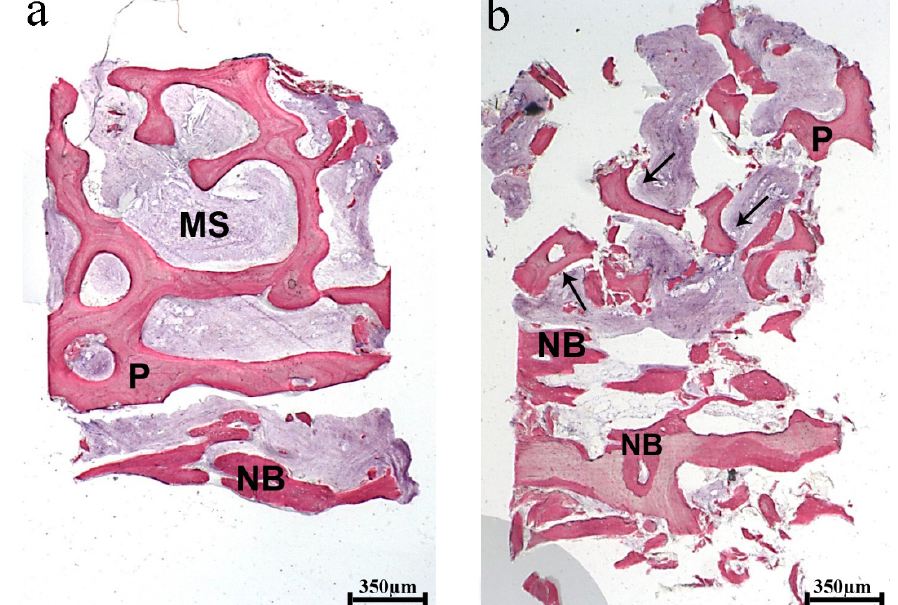
Figure 6. Histologic views: ( a ) light microscopic ground section of the specimen shows the biomaterial block (P), with a regular arrangement of the intact trabeculae. Large marrow spaces (MS) are present. In the marginal portion of the biopsy, only newly formed bone (NB) is observed; ( b ) this sample was damaged during the removal from the trephine bur, and, therefore, a portion of the biomaterial block was fractured (black arrows). The biomaterial (P) appears surrounded by soft tissues. In the marginal portion of the specimen, newly formed bone (NB) is observed. (Acid fuchsin-Toluidine blue 12 X). In many fields, biomaterial trabeculae were lined by newly formed bone, showing large osteocytes lacunae embedded into the newly formed bone, which was close to the biomaterial surface (Figure 7a).